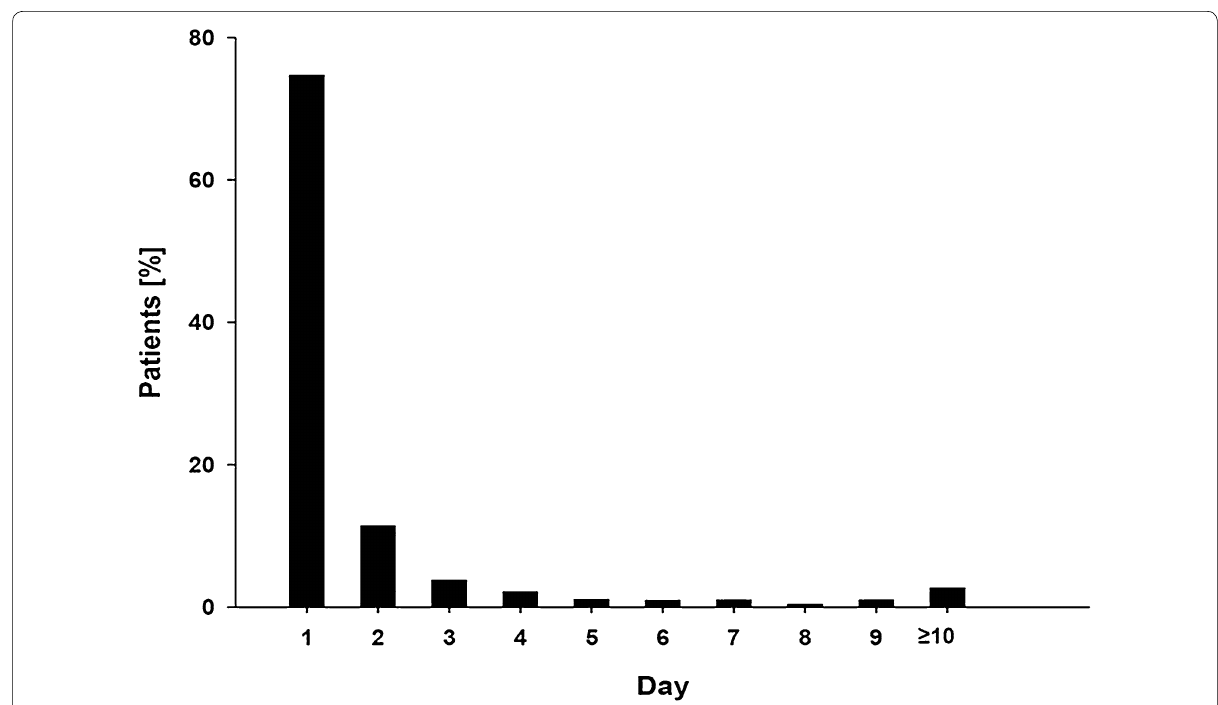
Fig. 2 Day of first colloid infusion in study patients receiving colloids. This figure depicts the day of ICU stay on which the patients receiving colloids were infused the first dose of